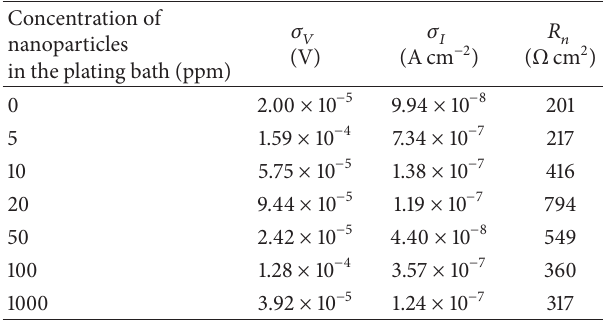
Table 4: Noise parameters of coatings in 0.5 M H electrochemical noise